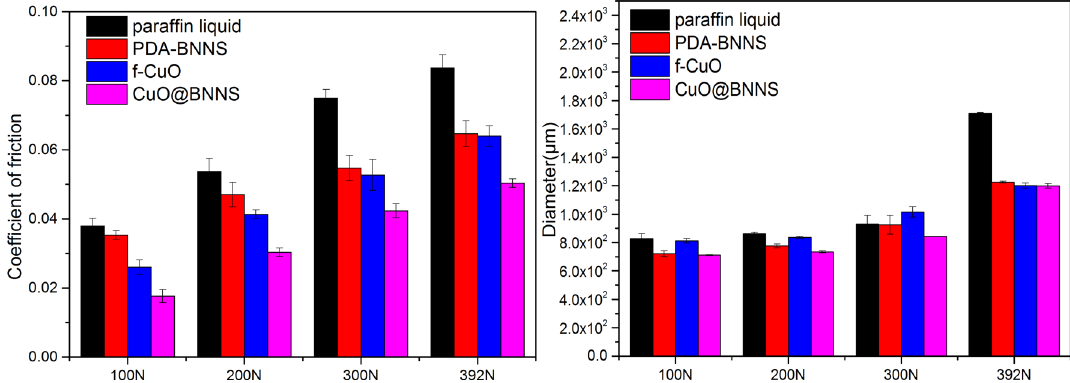
Fig.8 Coefficient of frictions and diameter of wear scar under different loads